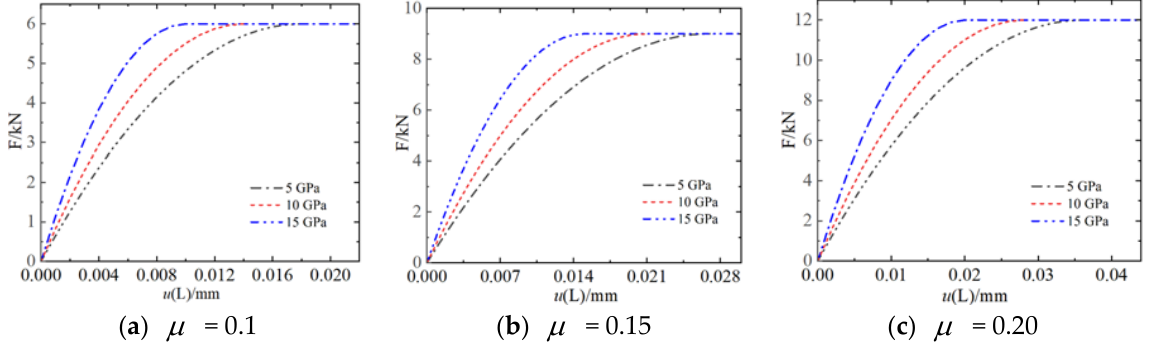
Figure 11. Force–displacement hysteresis skeleton curve.